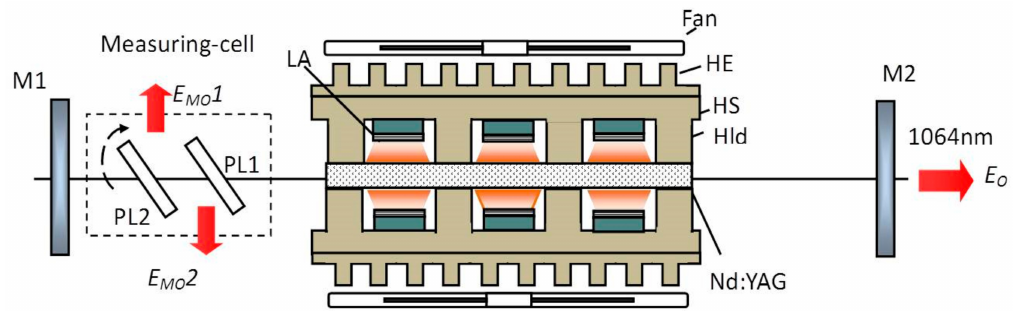
Figure 3. Schematic of the online measurement experimental arrangement.